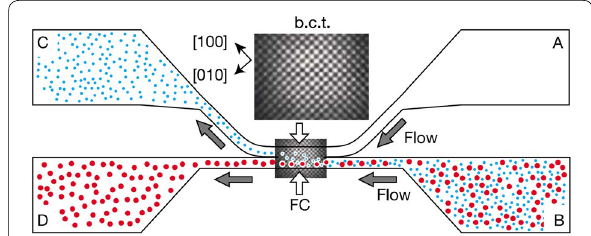
Fig. 7 A schematic diagram of the optical sorting system described by MacDonald et al. [140]. Chamber A contains buffer solution. Cham- ber B holds mixed particles. After passing through the optical lattice, selected particles are deflected into chamber C, while other particles flow straight into chamber D. The optimum lattice for fractiona- tion was a body-centered tetragonal (b.c.t.) lattice. FC denotes the fractionation chamber